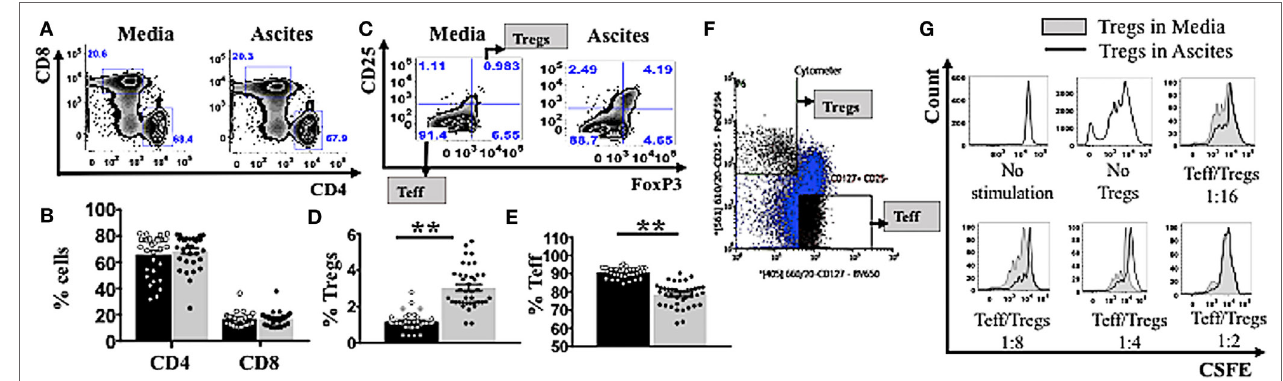
FigUre 1 | Ascites increases frequency of functional regulatory T cells (Tregs). (a–e) Peripheral blood mononuclear cells (PBMCs) from healthy donors ( n = 30) were isolated by Ficoll density centrifugation and incubated in vitro in either AIM V media or cell-free ascites from advanced epithelial ovarian cancer patients